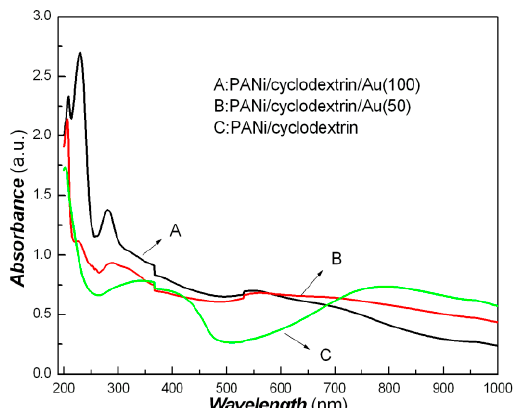
Figure 7. Representative UV–vis spectroscopy of a series of Au/PANi nanocomposites functionalized with beta-cyclodextrin. XRD of Au/PANi nanocomposites functionalized with beta-cyclodextrin was ex- 301